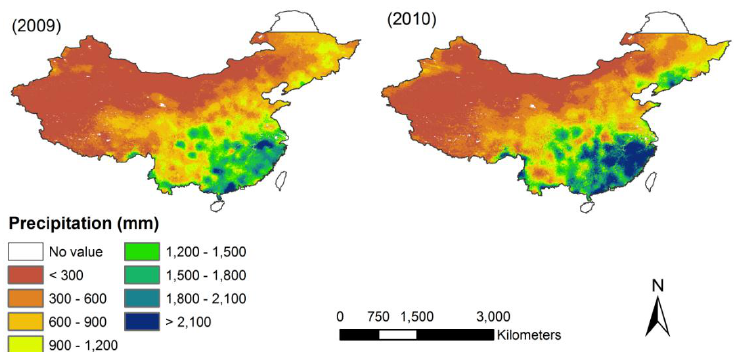
Figure A5. The final predicted annual precipitation of China mainland at the 1 km resolution from 2001 to 2010 using random Forest regression model. Conflicts of